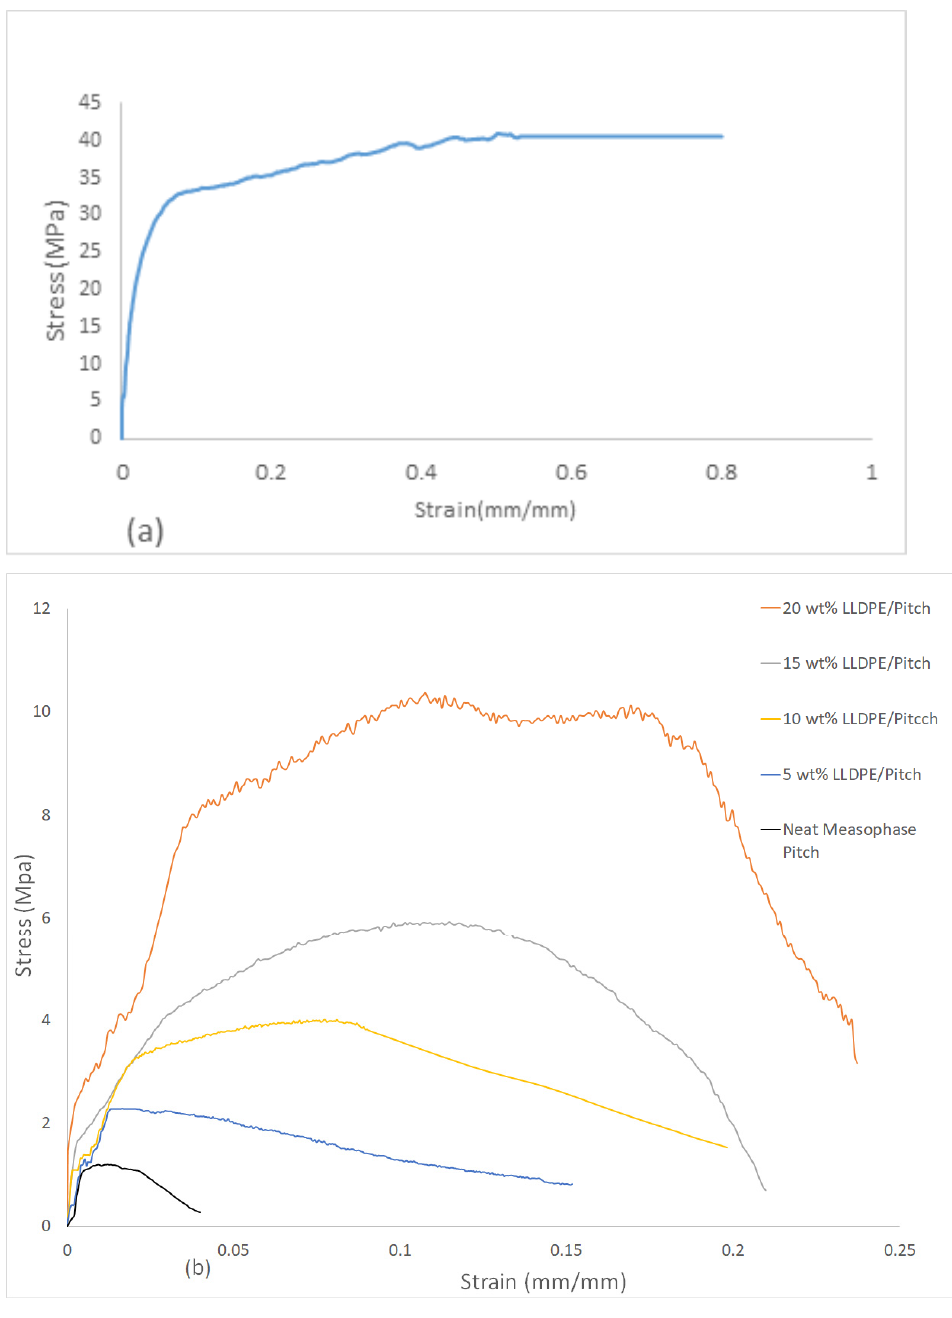
Figure 5. ( a ) Tensile strength of neat LLDPE; ( b ) Tensile strength of neat mesophase pitch fibres and LLDPE/mesophase pitch blend-based fibres with varying content of LLDPE. Table 3. Tensile strength, modulus, and strain at failure of the prepared samples.